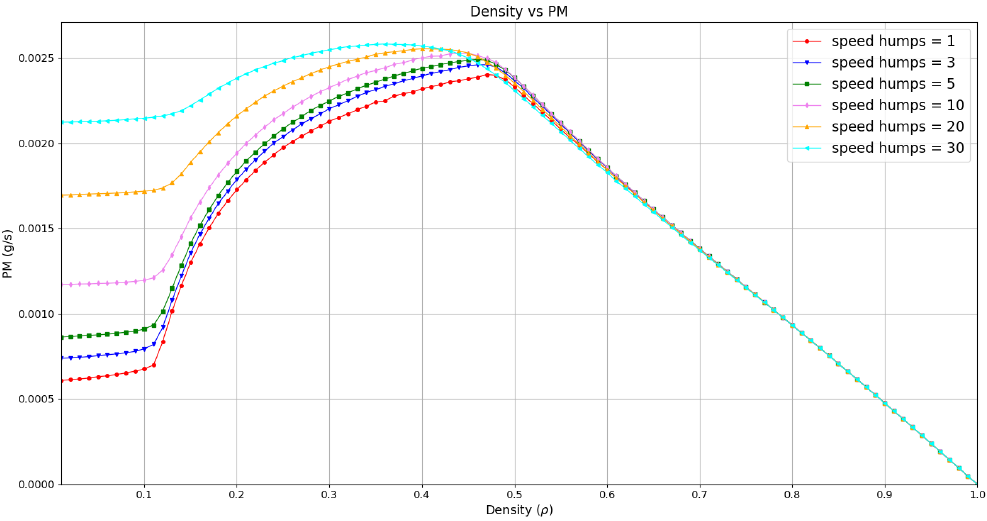
Figure 13. PM instant emissions as a function of